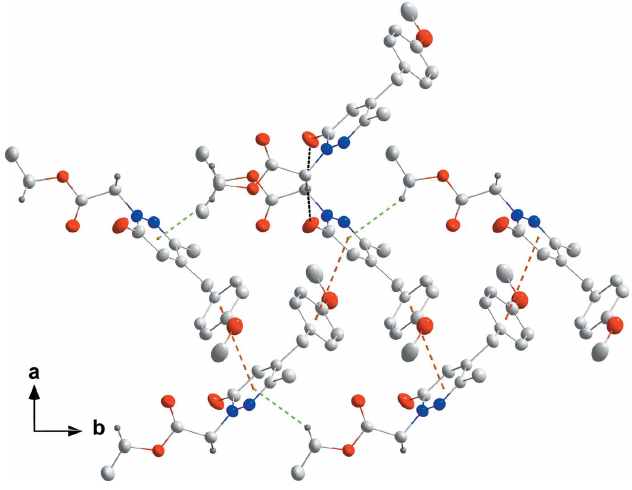
Figure 2 Detail of the intermolecular interactions viewed along the c -axis direction. C—H (cid:3)(cid:3)(cid:3) O hydrogen bonds are shown by black dashed lines while (cid:2) -stacking and C—H (cid:3)(cid:3)(cid:3) (cid:2) (ring) interactions are shown, respec- tively, by orange and green dashed lines.